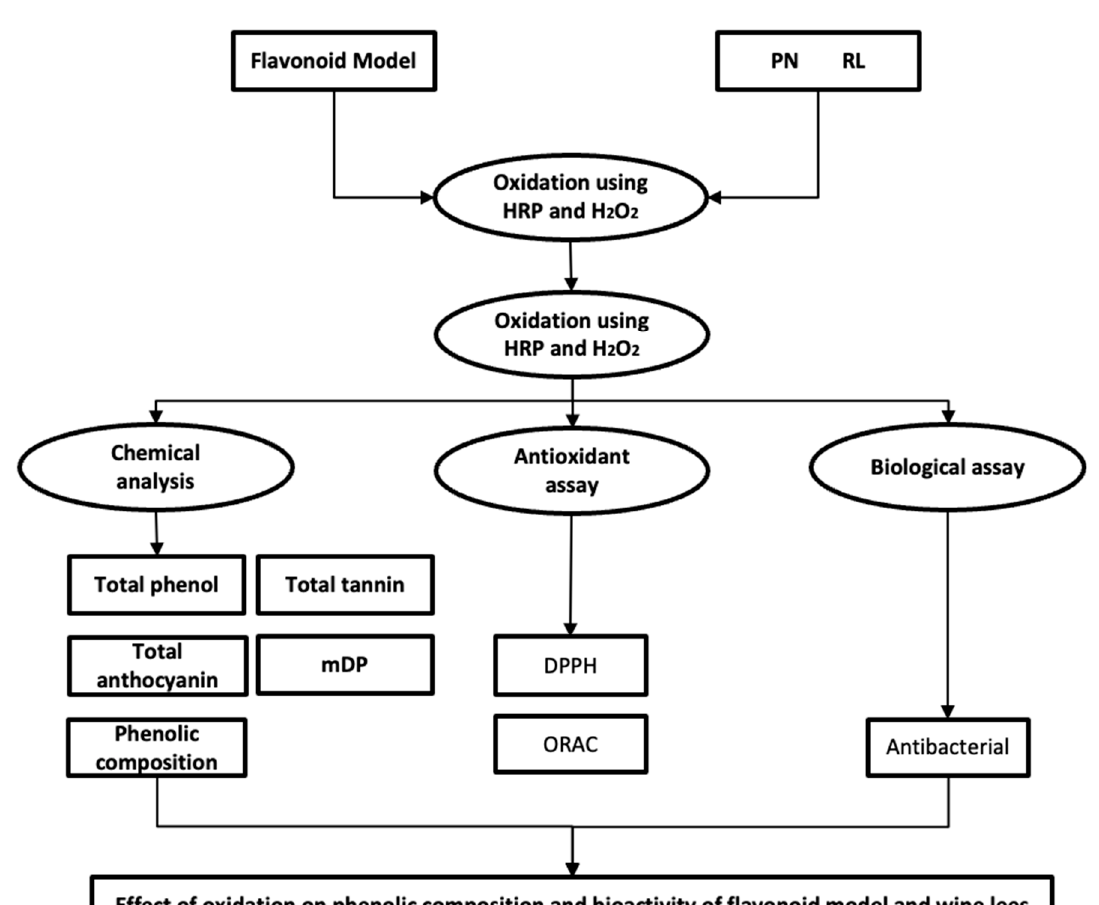
Figure A1. The experimental design.